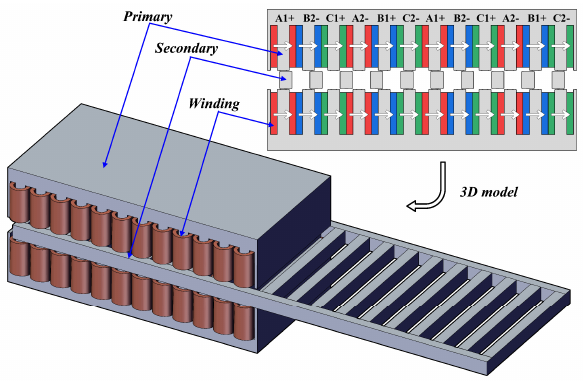
Figure 6. The DCB ‐ VRLM with non ‐ uniform air gap structure. Table 3. Key Parameters of DCB ‐ VRLM with Non ‐ uniform Air Gap Structure.